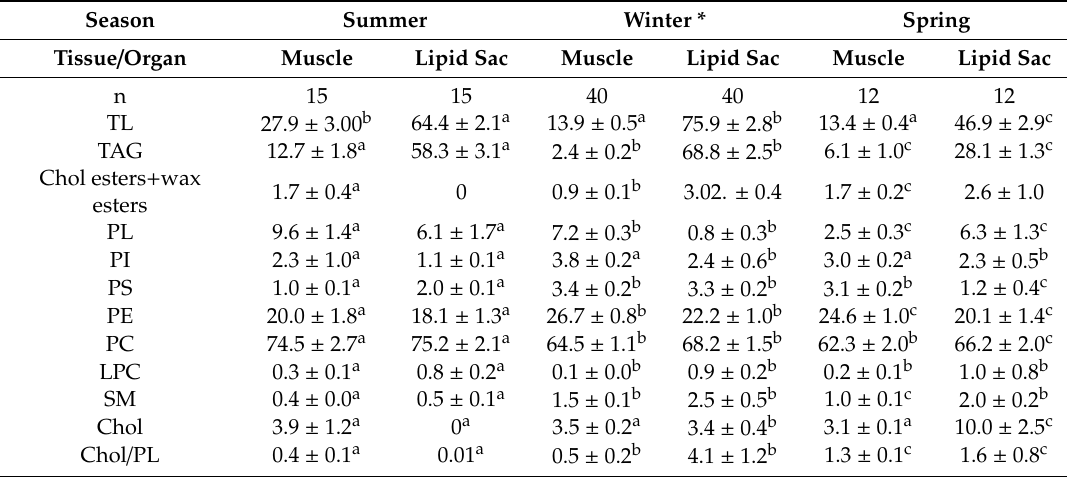
Table 2. Seasonal dynamics of total lipids and their individual classes (% of dry weight; % of total phospholipids for individual phospholipid classes) in the muscle and lipid sac of postlarval daubed shanny from Kongsfjord. Season Summer Winter * Spring Tissue / Organ Muscle Lipid Sac Muscle Lipid Sac Muscle Lipid Sac